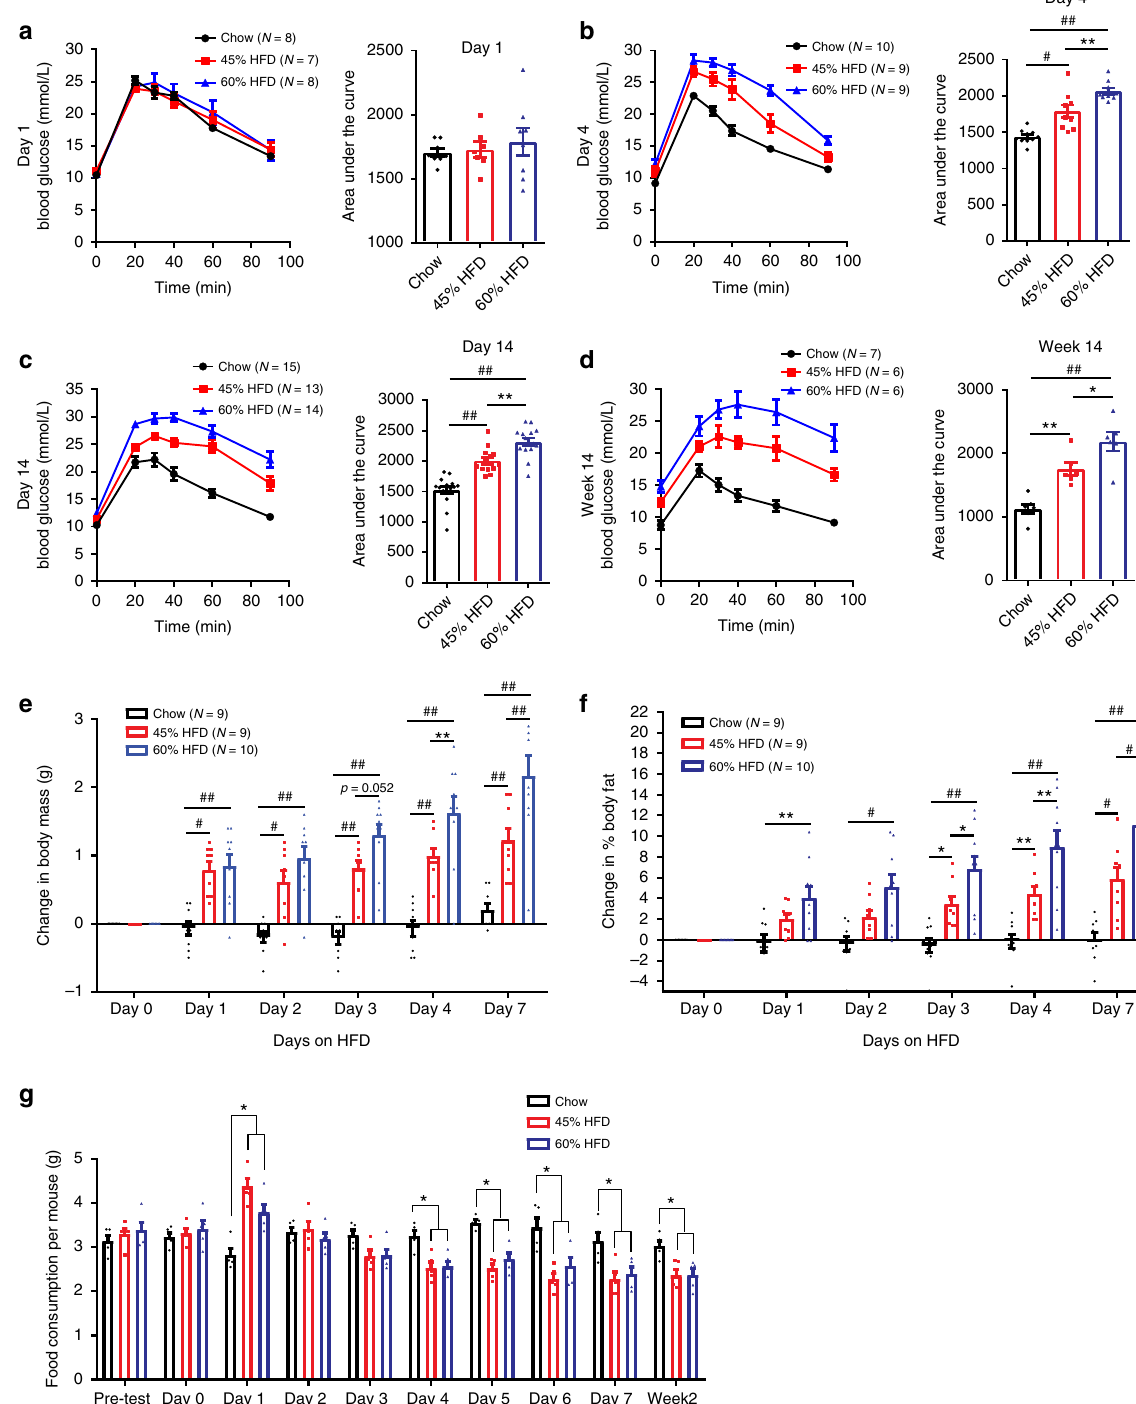
Fig. 1 Four days of an obesogenic diet is suf fi cient to induce glucose intolerance and increase adiposity in mice. a – d Mice were fed a chow, 45% HFD, or 60% HFD for 1 day ( a : N = 8, 7, 8), 4 days ( b : N = 10, 9, 9), 14 days ( c : N = 15, 13, 14), or 14 weeks ( d : N = 7, 6, 6) then tested for glucose tolerance with a 2 g per kg ( a – c ) or 0.9 g per kg ( d ) glucose dose by i.p . injection. Blood glucose measures were taken at indicated time points, which are shown in the glucose tolerance test (GTT) curve and used to calculate the area under the curve (AUC). Statistical signi fi cance was measured as p < 0.05 using one-way ANOVA. Post hoc analysis was performed using Tukey ’ s multiple comparisons test (* p < 0.05; ** p < 0.01; # p < 0.001; ## p < .0001). Change in body weight ( e ) and change in % body fat ( f ) were calculated as the difference between Day 0 and subsequent days within each animal. Body weight and adiposity (% body fat) were measured in mice fed a chow, 45% HFD, or 60% HFD for 7 days ( N = 9, 9, 10). Statistical signi fi cance was measured as p < 0.05 using two-way ANOVA with repeated measures (time). Post Hoc analysis was performed using Tukey ’ s multiple comparisons test (* p < 0.05; ** p < 0.01; # p < 0.001; ## p < .0001). g Food consumption ( N = 5 cages per group) was measured daily and expressed per mouse. Statistical signi fi cance was measured as p < 0.05 using one-way ANOVA for each time point. Post hoc analysis was performed using Tukey ’ s multiple comparisons test (* p < 0.05). All values are mean ±